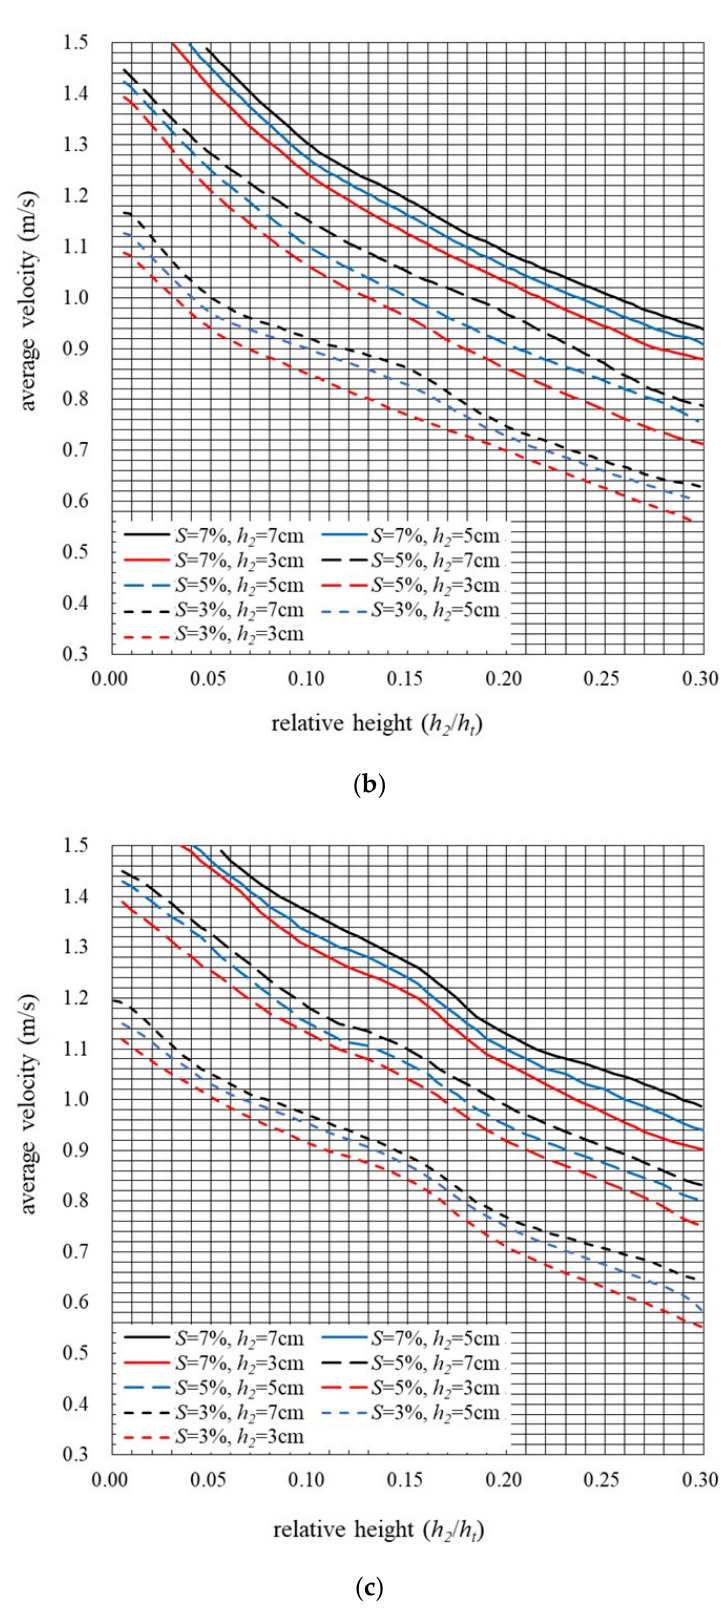
Figure 7. Relationships between the average flow velocity and the relative height in grassed channels covered with ( a ) Centipede grass, ( b ) Bermuda grass, and ( c ) Carpet grass.